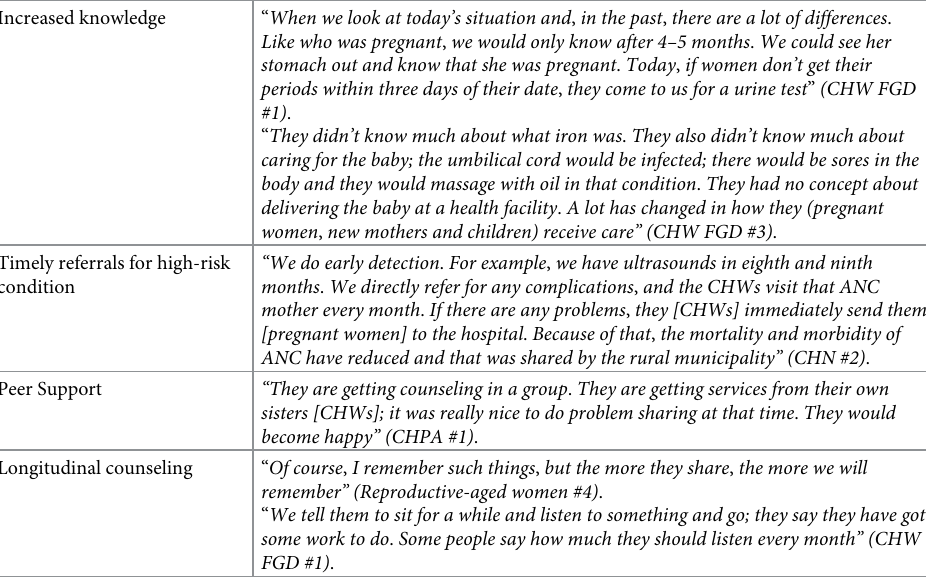
Table 5. Illustrative quotes of perceived mechanisms of impact of the